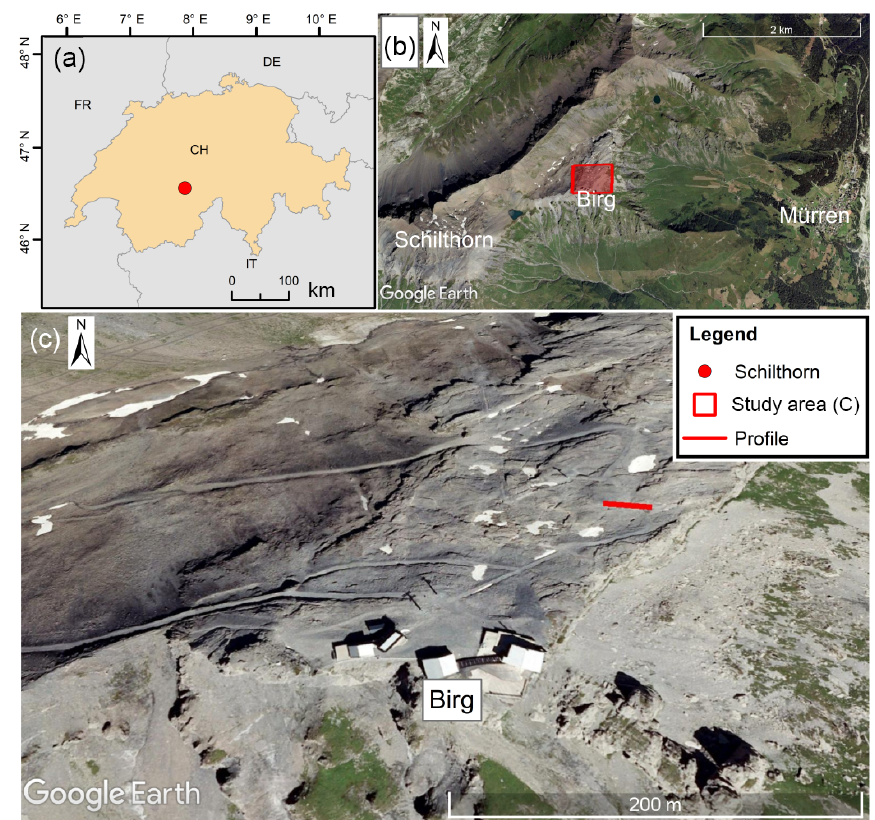
Figure 1. Geographical maps of the Schilthorn area. Panel (a) shows the location in Switzerland. In panel (b) the Schilthorn area with the village Mürren, the mountain station Birg and the summit is shown (© Google Earth). The area around Birg where the measurements took place is shown in panel (c) , including the location of profile B-SCH (© Google